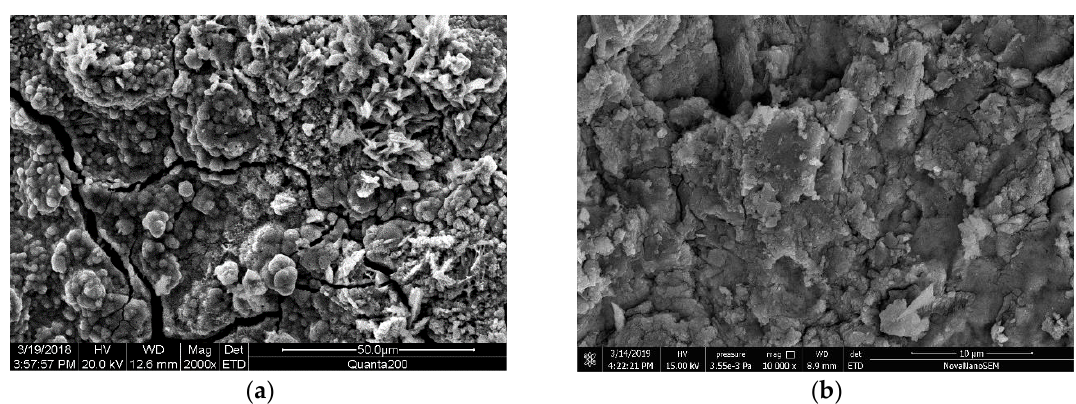
Figure 9. SEM images of rust layer in seawater and sea-sand concrete under dry-wet cycle; ( a ) Initial rust layer morphology of A2, ( b ) Later rust layer morphology of A2.